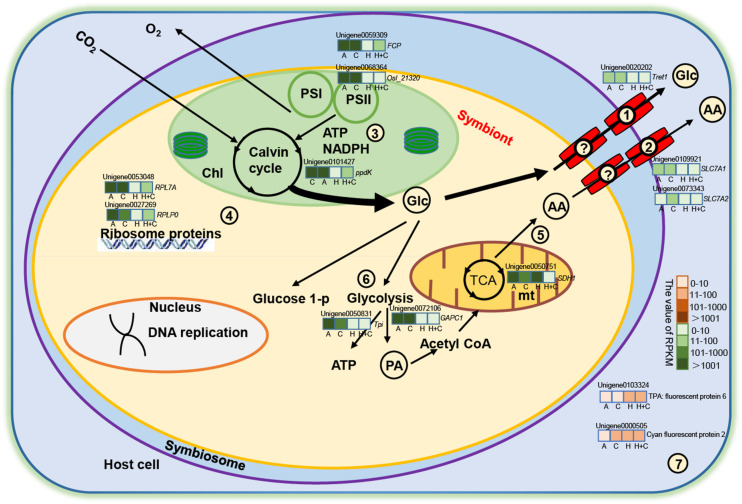
Metabolic integration of coral and Symbiodiniaceae. Only metabolic processes and several genes considered directly related to the study are shown. The question mark indicates that no DEGs for transporter were detected in the symbiont. Glucose transporter from symbiont (?), amino acid transporter from symbiont (?), glucose transporter from coral (1), and amino acid transporter from coral (2). (3) Photosynthesis and the Calvin cycle. (4) Ribosomal protein. (5) The TCA cycle. (6) Glycolysis. (7) Fluorescent protein. Red and green color scale represents upregulation and downregulation, respectively. AA, amino acid; Chl, chloroplast; Glc, glucose; mt, mitochondria; PA, pyruvate; TCA, tricarboxylic acid cycle. Italic letters around unigenes are annotation genes (i.e., RPL7A), and Arial letters are annotation proteins (i.e., cyan fluorescent protein). Unigenes in the schematic are selected by key genes, differential expression (up/down), and the value of RPKM (widely varied). The color variations in green (down expression) and orange (up expression) bar mean that the values of RPKM range from 0 to 10, 11 to 100, 101 to 1,000, and >1,000. Each gene box is equally divided into four pieces (A, C, H, and H+C), sequentially representing ATAC, ATHC, HTAC, and HTHC treatment, respectively.